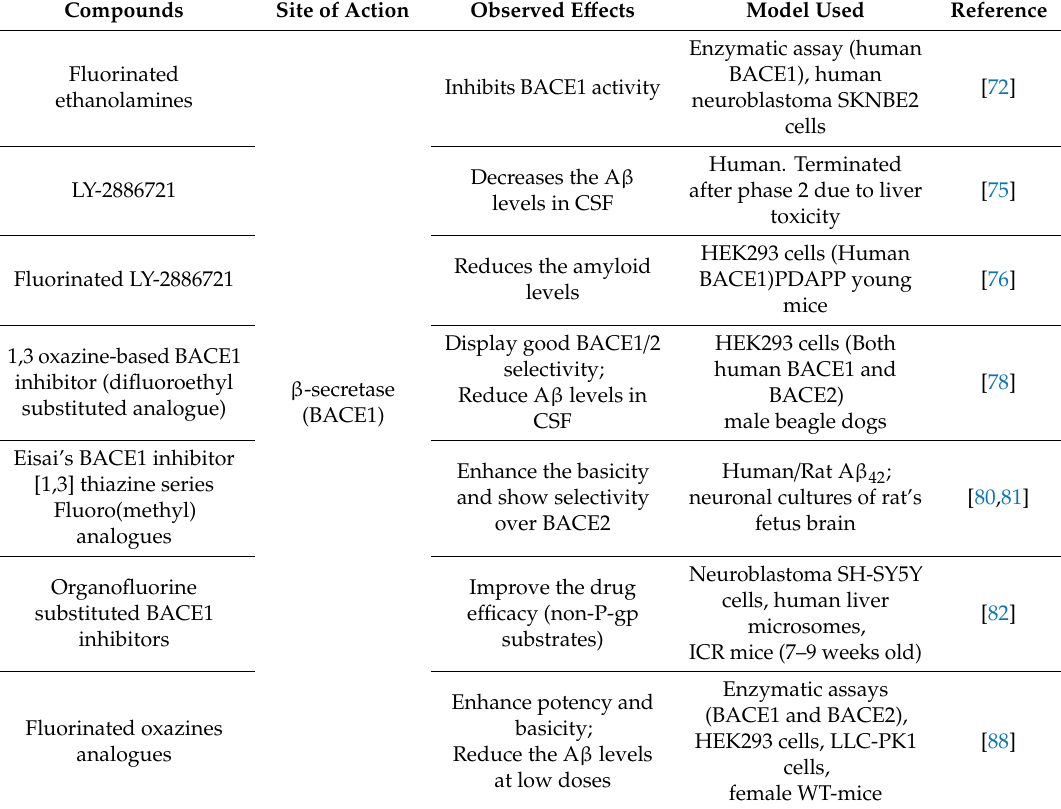
Table 2. Fluorinated BACE1 inhibitors for the Alzheimer’s disease (AD)